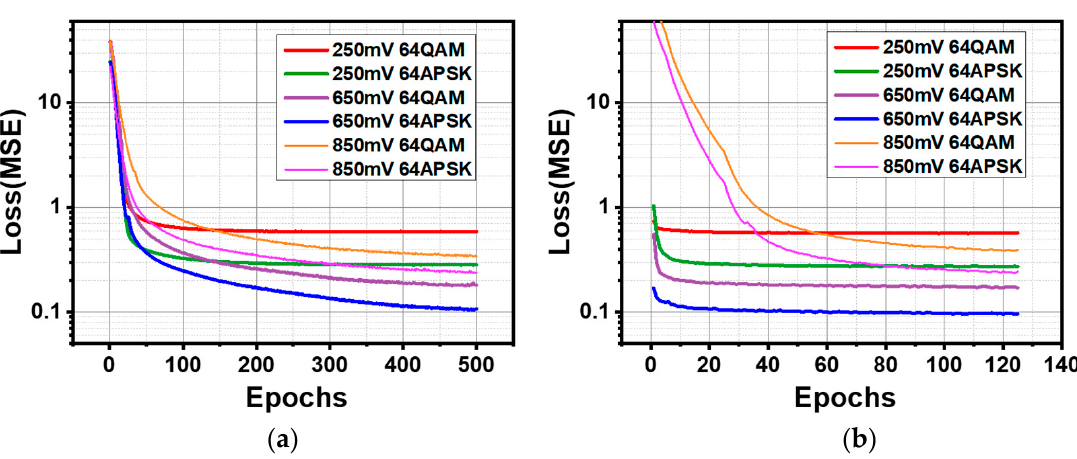
Figure 7. Loss curve in exhaustive ( a ) and transfer learning strategy ( b ). Transfer learning strategy has a significant advantage in converging speed. Higher signal power results in more complex non- linearity and thus requires more training iterations.